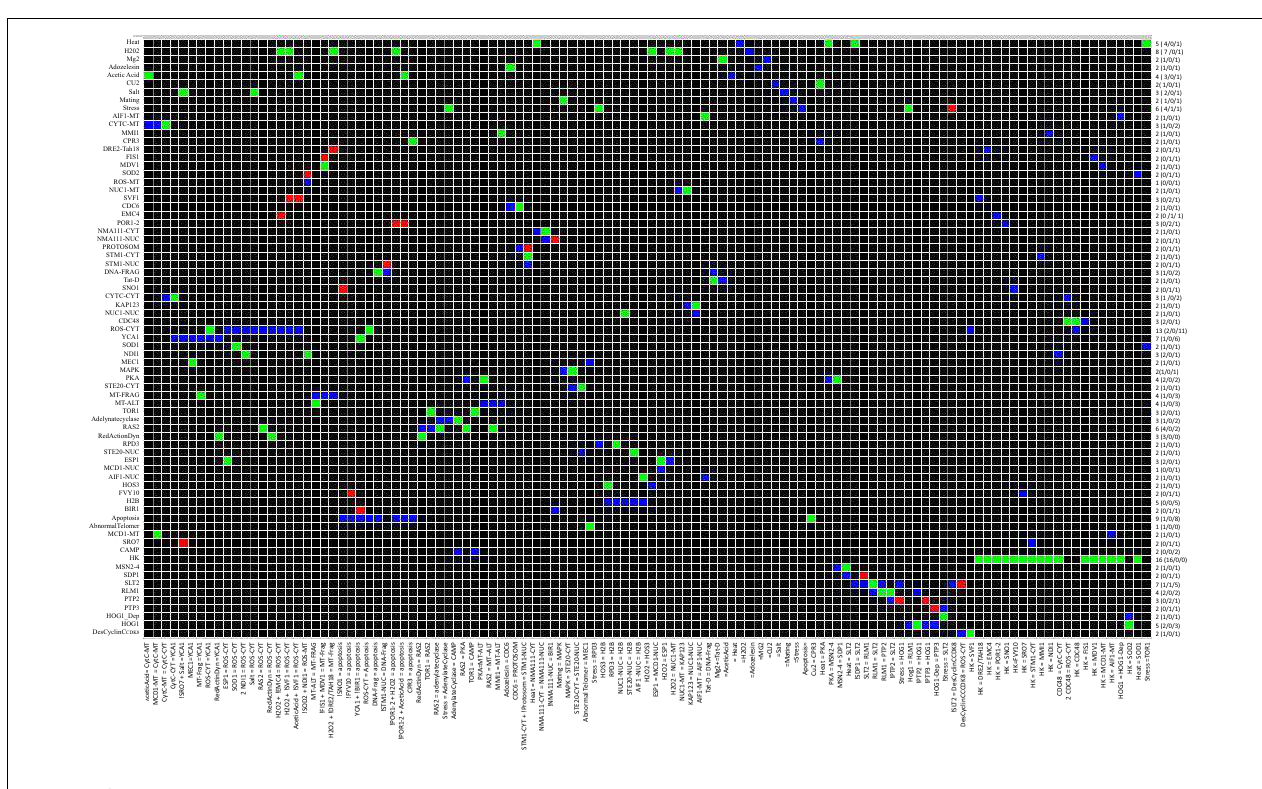
having dark or light red indicates species i is a total inhibitor or non-total inhibitor of species j . whenever there is no path from spices i to species j the intersection cell is field by black.The hyper graph underlying the network is a directed graph and consequently the dependency matrix is non-symmetric. (Color coding: light and dark green – complete and incomplete activation, dark and light red – complete and incomplete inhibitor, yellow indicates an ambivalent factor and black indicates that there is no dependency between two